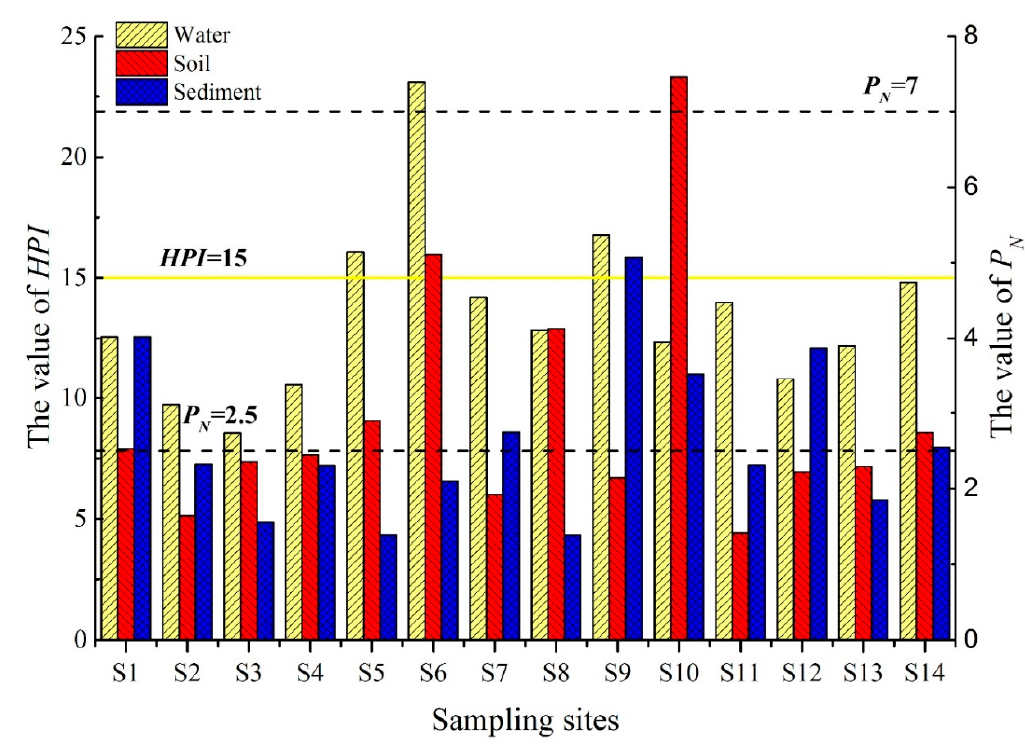
Figure 3. Heavy metal pollution index ( HPI ) of water, Nemerow pollution index ( P N ) of sediment and riparian soil in Songhua River.